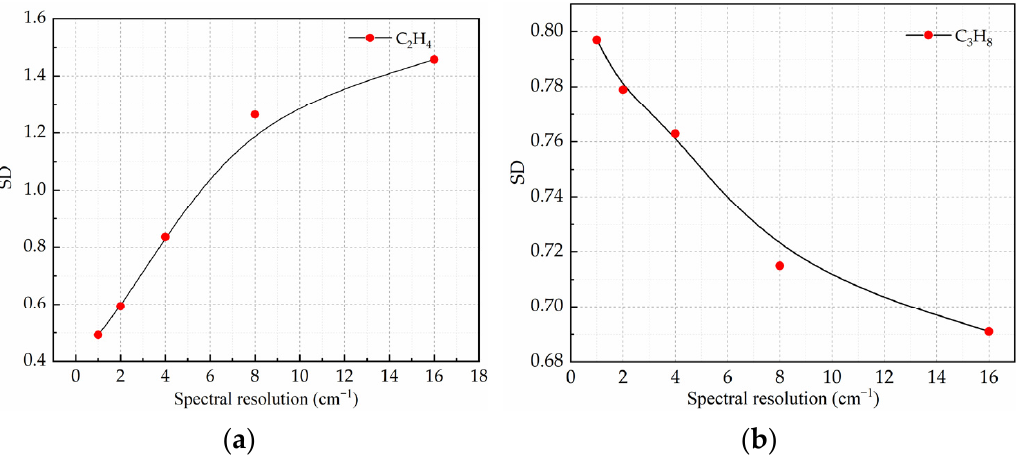
Figure 8. ( a ) The standard deviation of C 2 H 4 concentration with different spectral resolutions; ( b ) the standard deviation of C 3 H 8 concentration with different spectral resolutions.